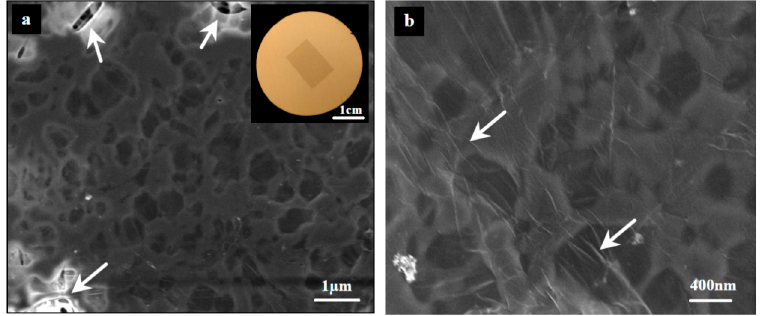
Figure 13. FESEM micrograph of transferred graphene (~1 × 1 cm 2 ) onto PP substrate. The white arrow on the left image indicates the tears in the graphene upon transfer [54]. Materials 2017 , 10 , 86 11 of 15